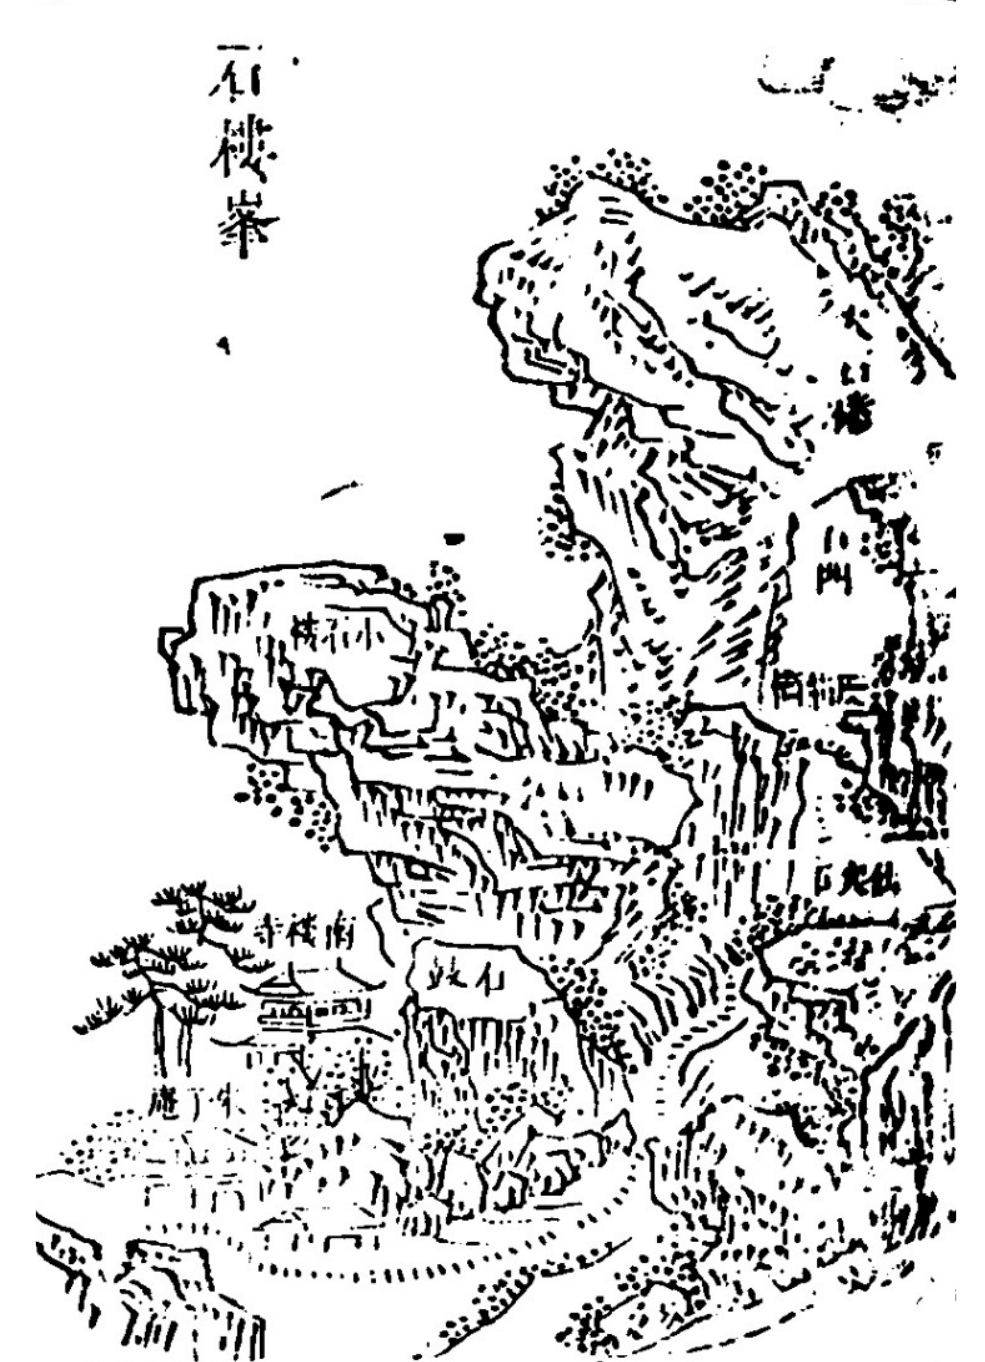
Figure 14. Image of the Shilou Feng, 1639. Woodblock print. After Han Huang, Luofu yesheng , 2.46a (522).